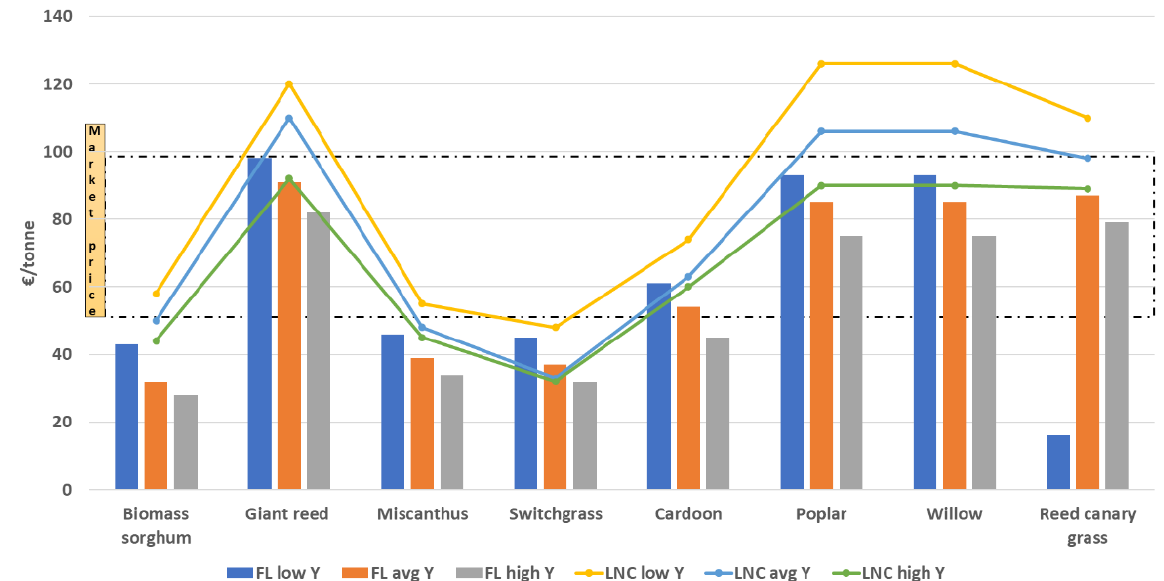
Figure 5. Lignocellulosic crops production cost ranges in € /tonne (with yield increases) in farming land (FL) and in land with natural constraints (LNC). Details in Table 4.